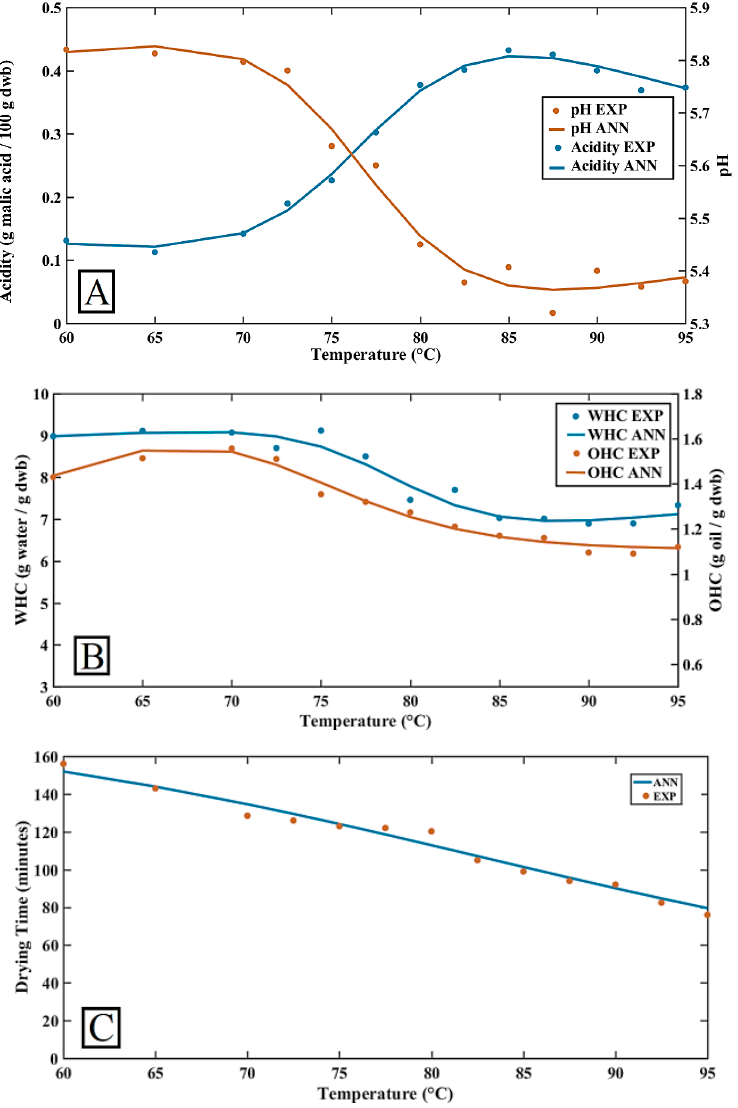
Figure 8. Predictions (ANN) and experimental results (EXP). ( A ) Acidity and pH, ( B ) WHC and OHC, ( C ) Batch time. Table 4. Utopia vector.